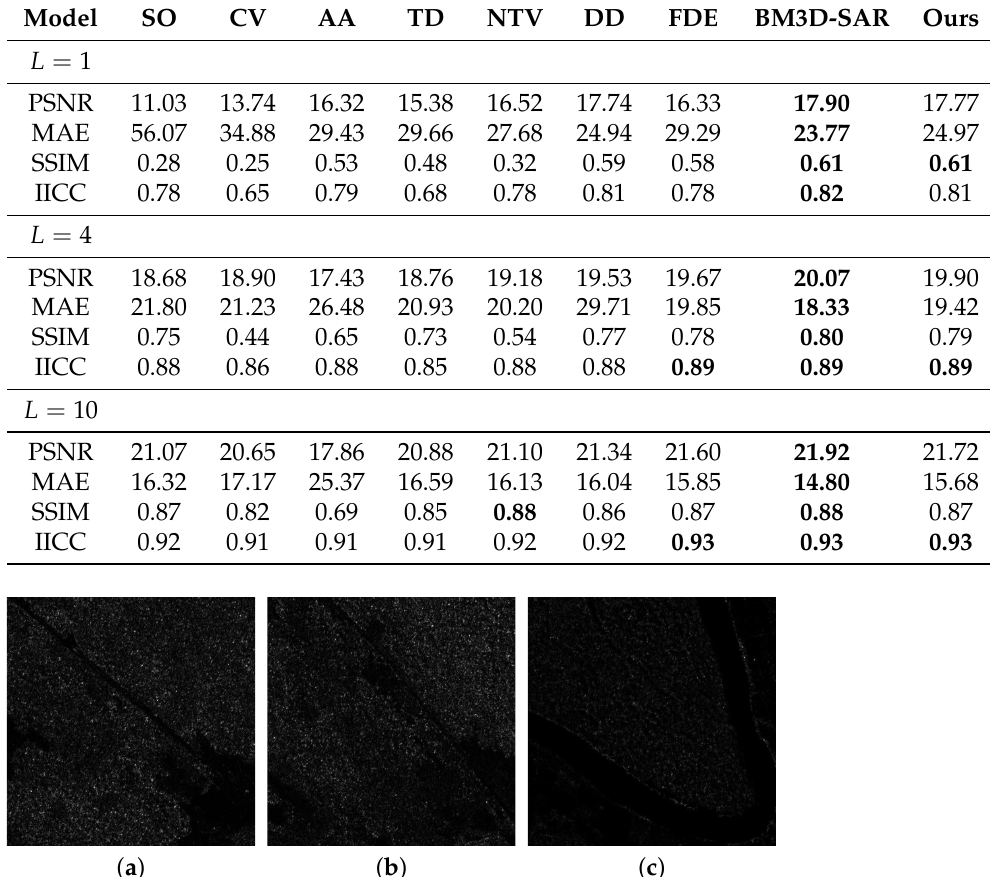
Table 6. Quantitative comparison of the different models for the satellite2 image.